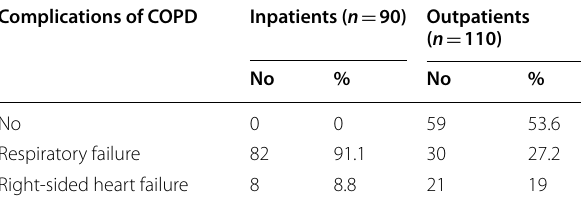
Table 7 Distribution of the two studied groups according